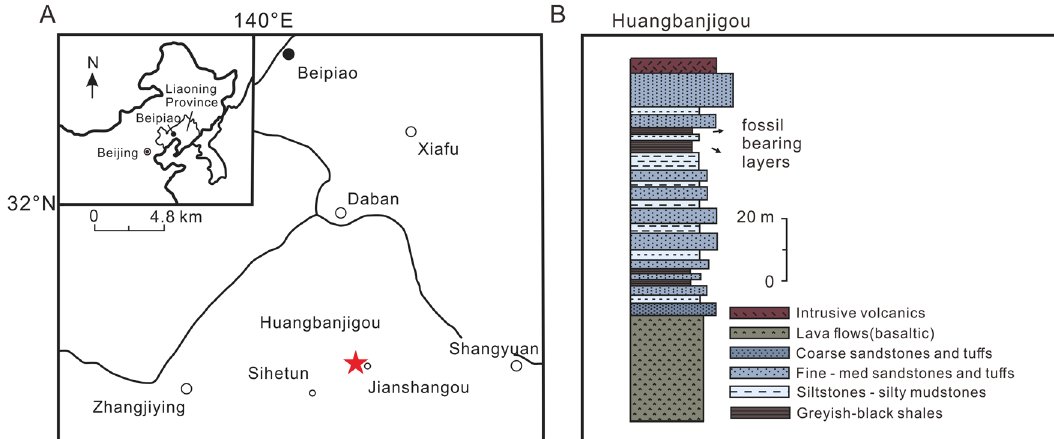
Figure 1. Geographical and stratigraphic context of the Yixian Formation, after Liu et al. 54 . ( A ) Map of the western Liaoning Province, 56 with the red star indicating the fossil locality at Huangbanjigou (modified from Cai et al. 55 ). ( B ) Fossiliferous strata exposed in Huangbanjigou (modified from Wang et al. 56